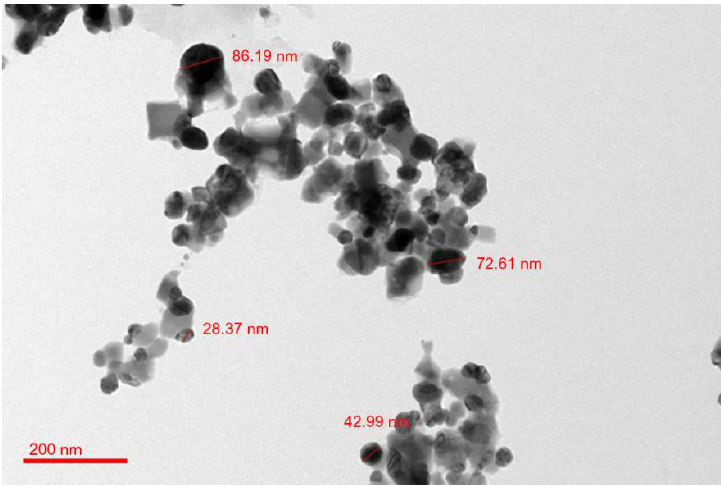
Fig. 7. Panchagavya mediated spherical shaped Ag NPs (Reproduced from ref.